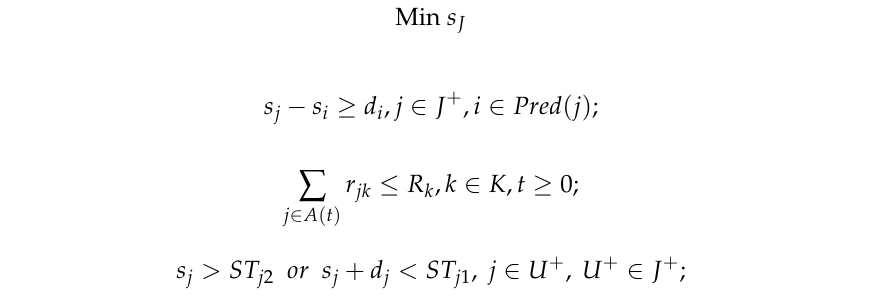
Figure 3. Schedule 2.